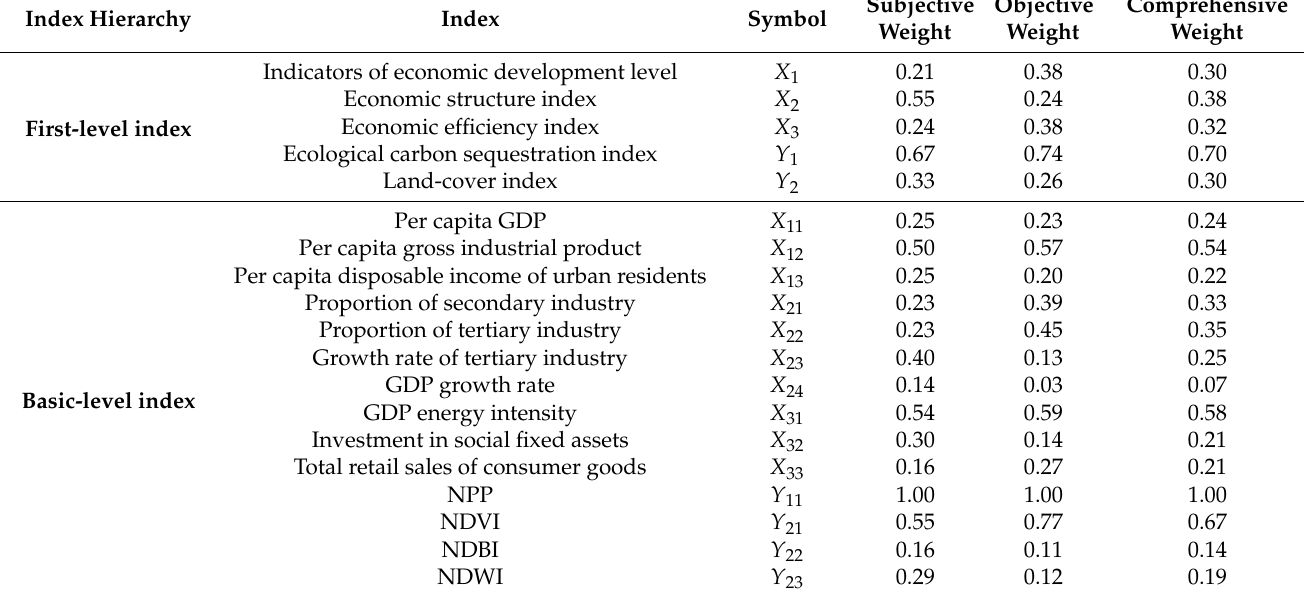
Table 2. Weights of